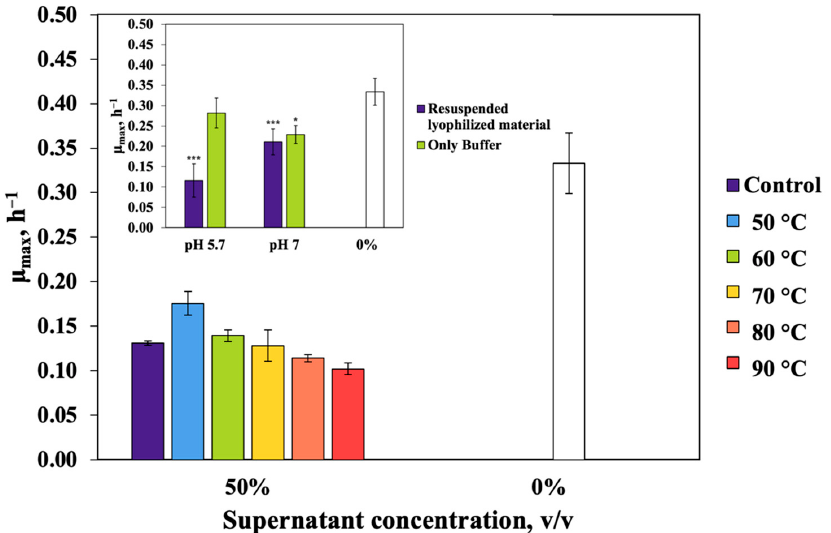
Figure 5. Effects of temperature and pH on antimicrobial activity of the Zm4 culture supernatant. Effect of thermal pretreatment at various temperatures on the E. coli specific growth rate. Duration of pretreatment, 20 min; control, without pretreatment. In all cases, supernatant addition signifi- cantly decreased the growth rate ( p < 0.001). Inset: The pH dependence of the inhibitory effect of concentrated Zm4 culture supernatant in 0.2 M citrate buffer. Empty bars, E. coli specific growth rate without any additions. * p < 0.05; *** p < 0.001.